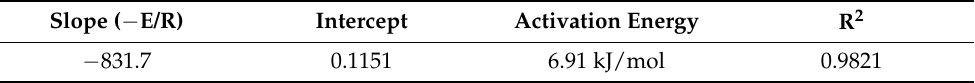
Table 8. Arrhenius equation. Adjustment data at 100, 110 and 120 ◦ C by using Equation (15).